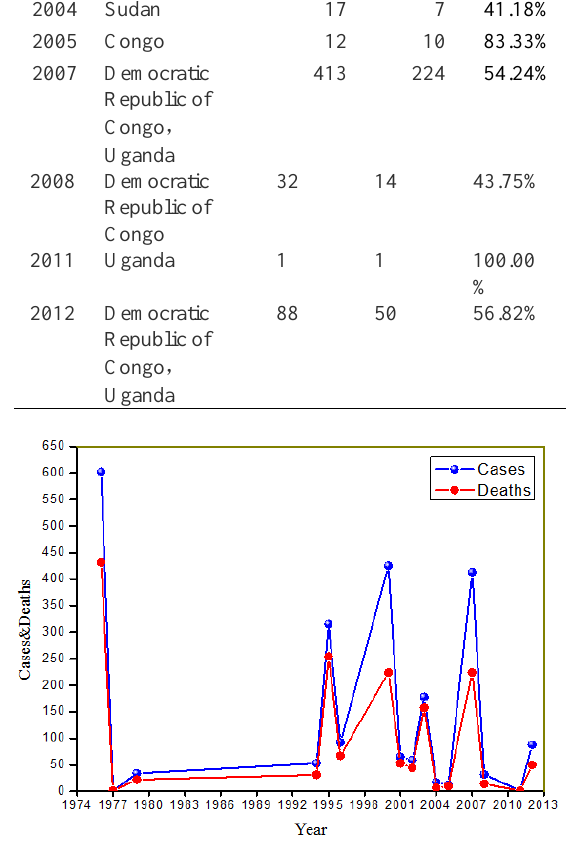
Figure 1. Epidemic curve of global EVD incidence and mortality from 1976 to 2012.